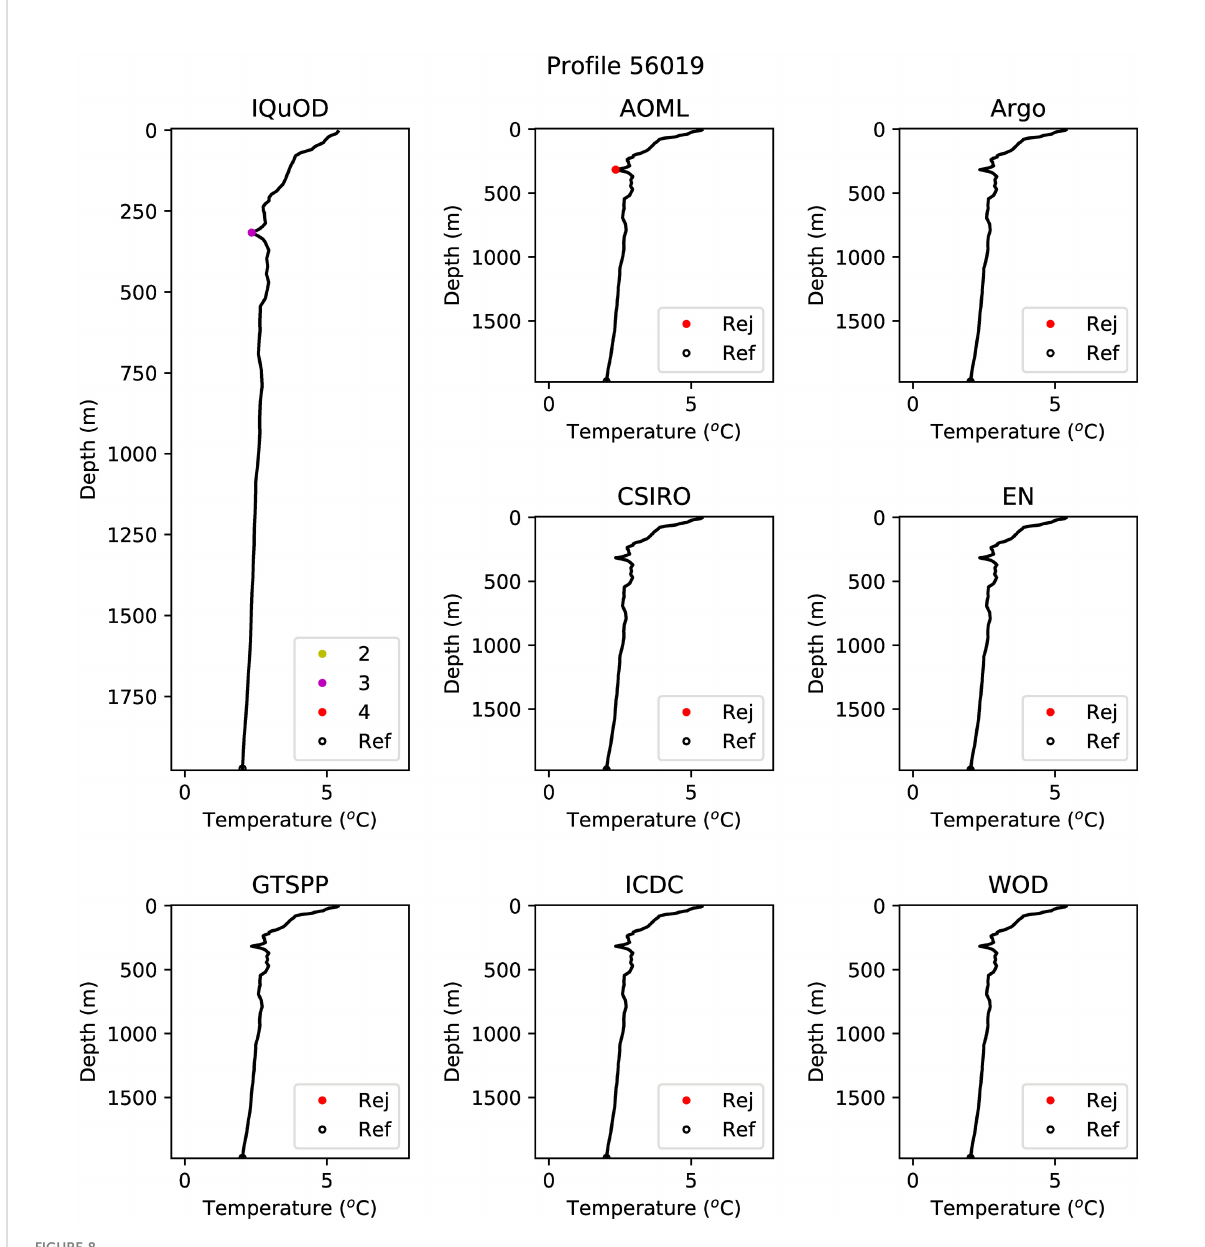
FIGURE 8 As Figure 3 except for an example Argo pro fi le - number 56019 in the data analyzed for the Paci fi c Ocean - at 57.344°S, 170.453°E on 29 December